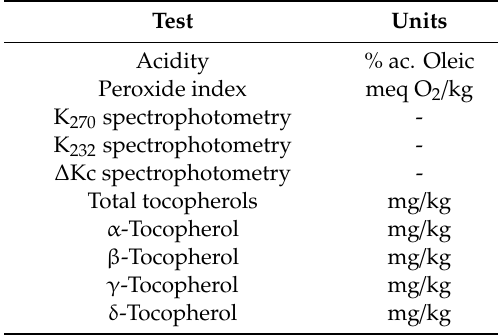
Table 4. Determinations carried out by the accredited external